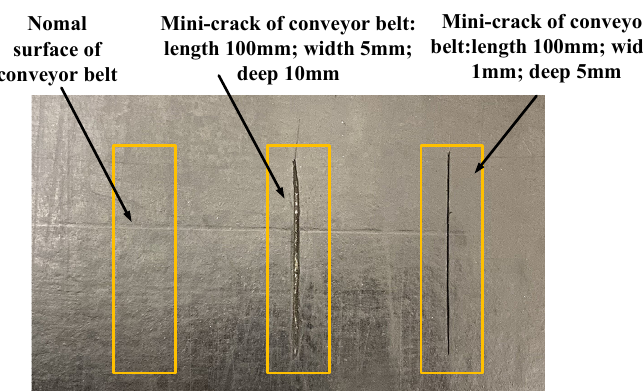
Figure 9. Mini-crack category of conveyor belt (length = 150 mm; width = 250